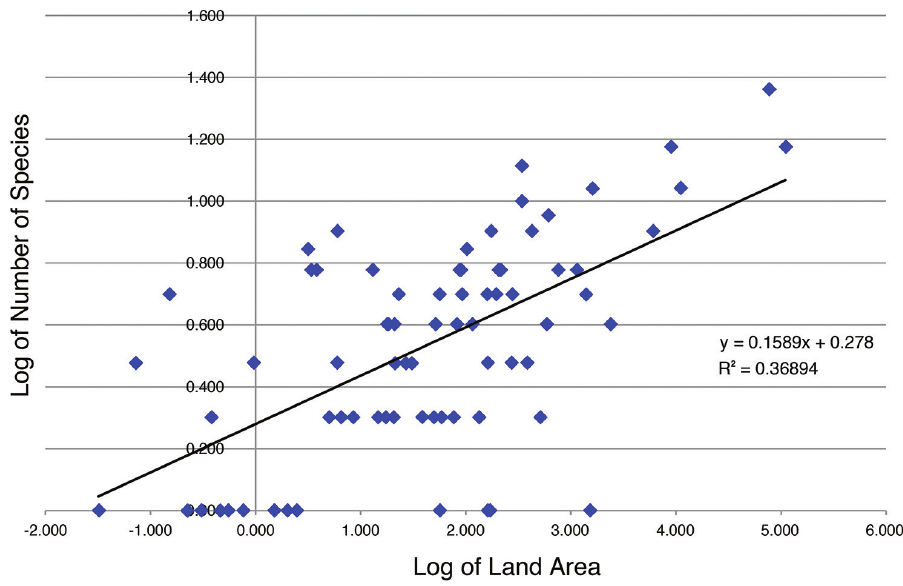
Figure 72. Data analysis of log of number of Selenophori species plotted against log of island